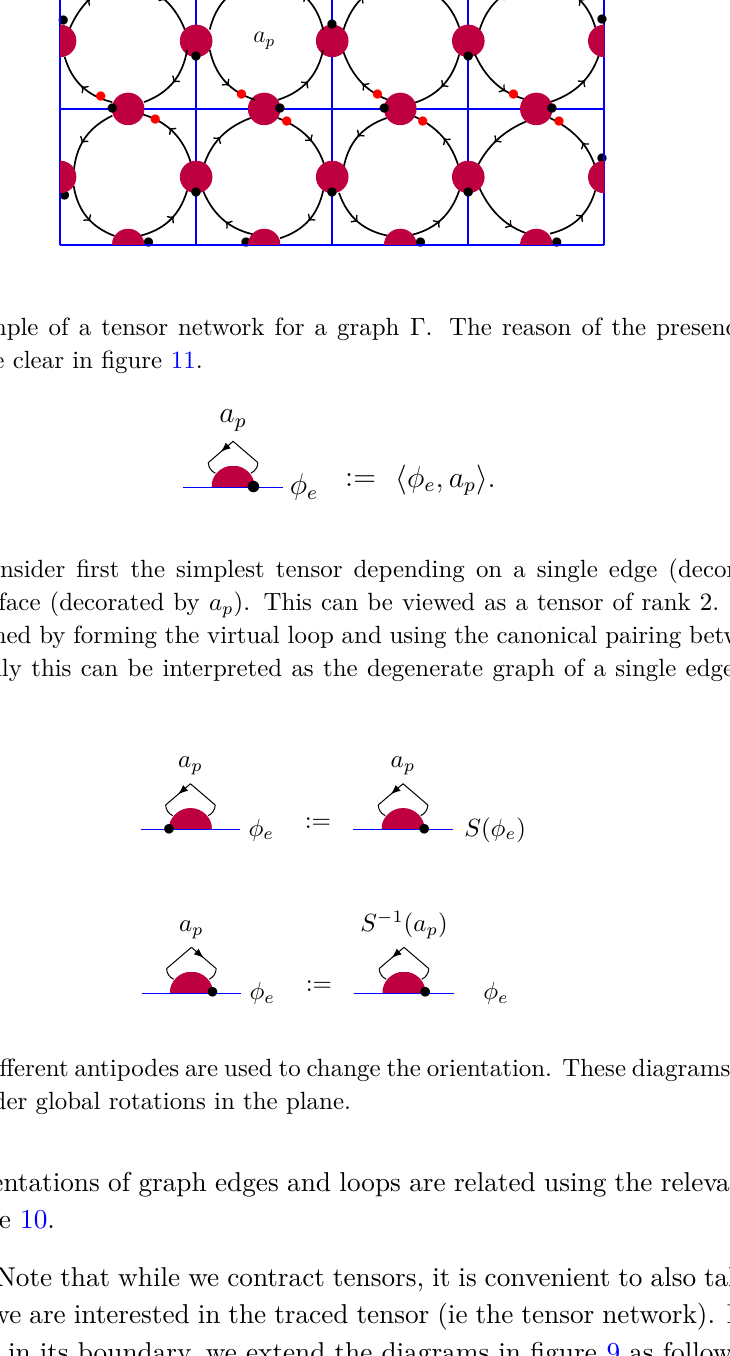
figure 11. Here the arrows indicate the order in which the coproduct of a basic diagrams. The red dot indicates the origin of this